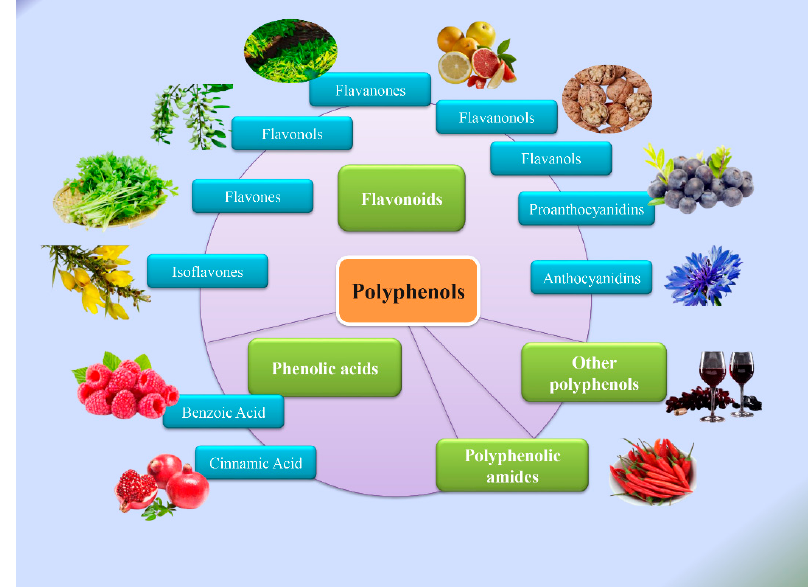
Figure 1. Classification of polyphenols. Molecules 2022 , 27 , 8810